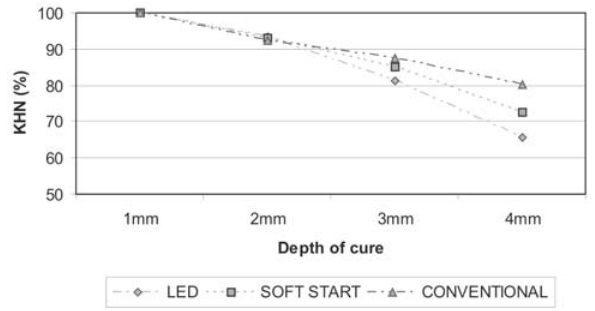
FIGURE 1- Percentage of KHN regarding depth of